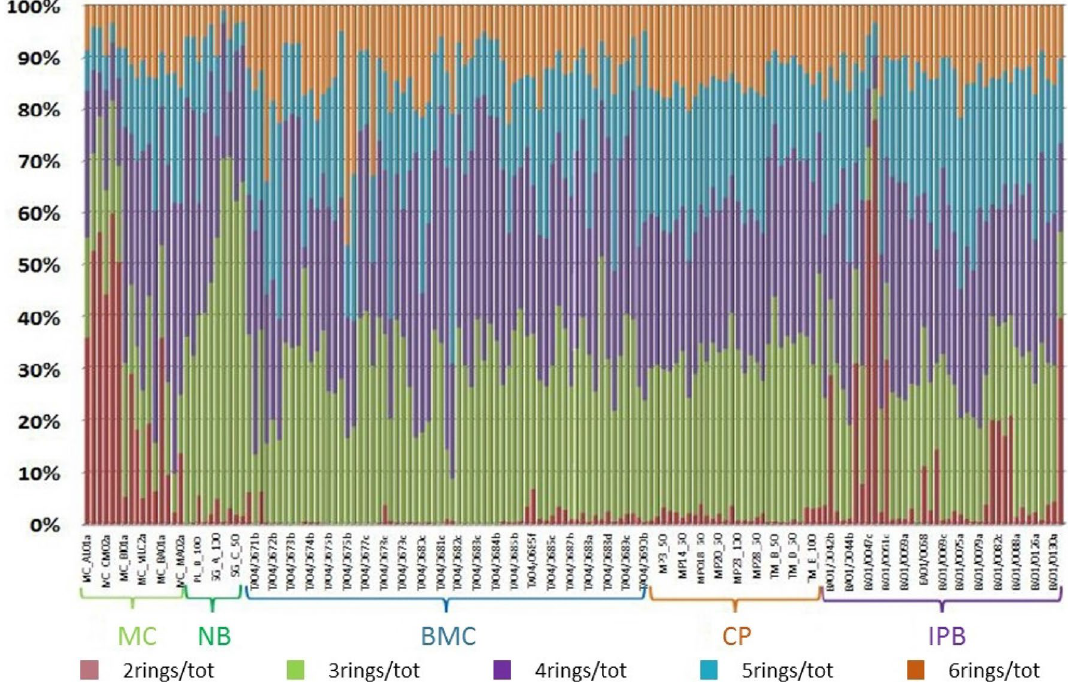
Figure 2. Percentage of 2-, 3-, 4-, 5-, and 6-ringed PAHs with respect to Σ16PAHs (where Σ16PAHs is indicated shortly as